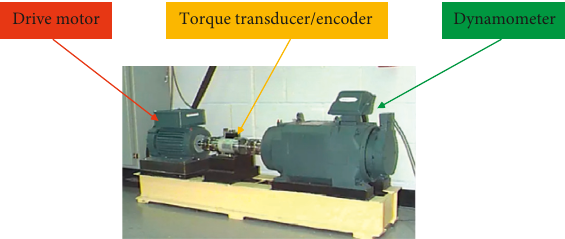
Figure 7: Rolling bearing failure simulation test bench of Case Western Reserve University. Table 1: Test bearing